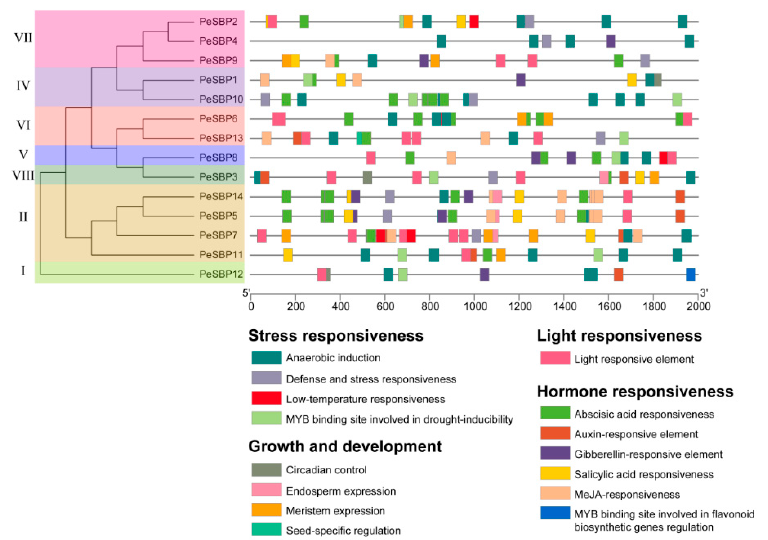
Figure 8. The distribution of cis -acting elements identified in the 2000-bp upstream promoter region of PeSBP genes.